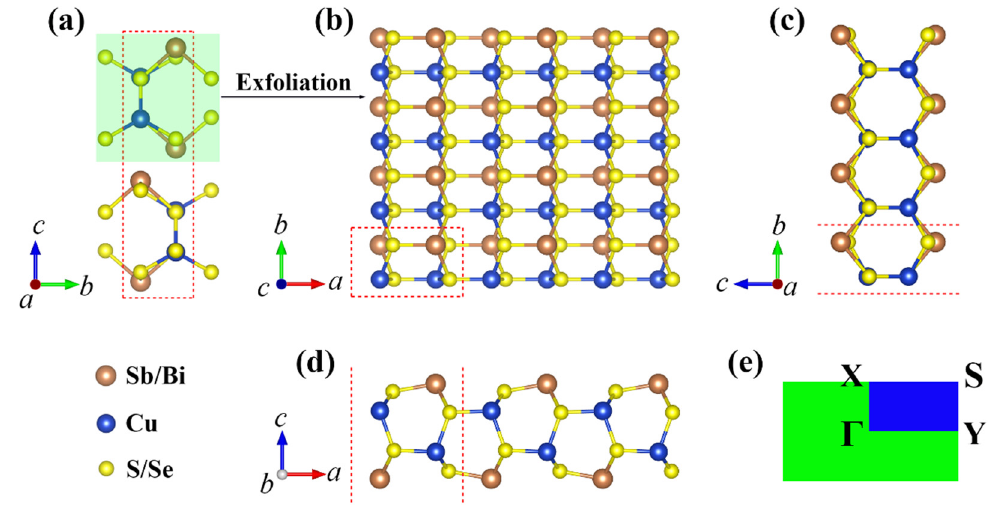
Figure 1. The structures of: ( a ) bulk; ( b ) top view; ( c , d ) side view; and ( e ) K-point path of 2D CuMN 2 (M = Sb, Bi; N = S, Se). Table 1. The structural parameters, buckling height h , cleavage energies E f , and band gaps E g of 2D CuMN 2 (M = Sb, Bi; N = S, Se).